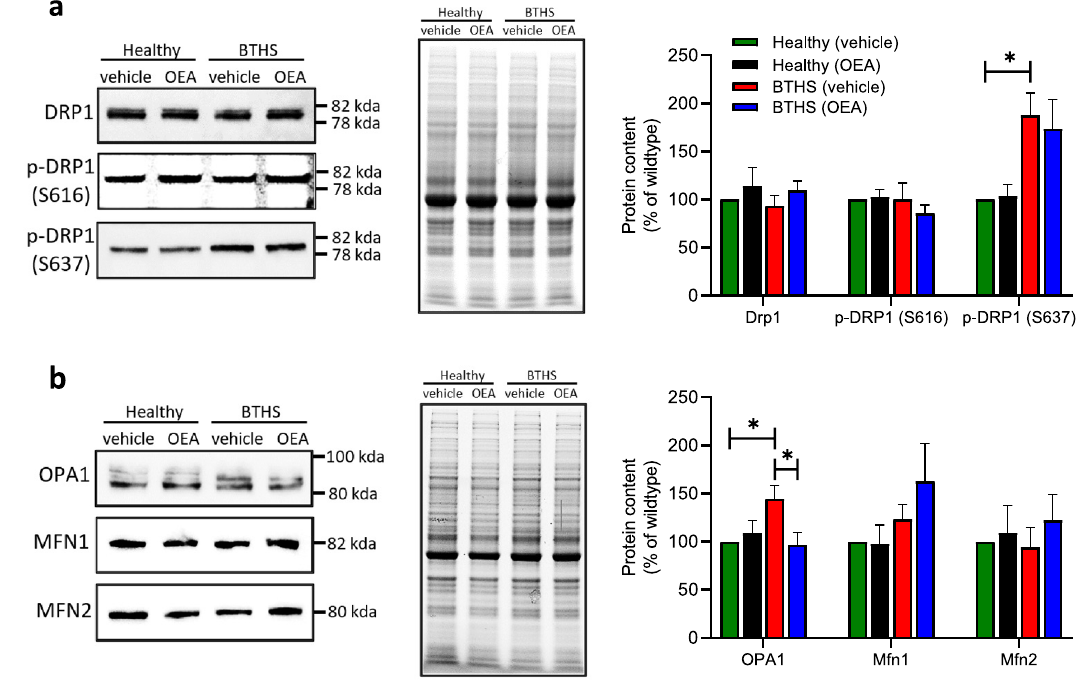
Figure 5. OEA treatment attenuated the elevated expression levels of OPA1 in BTHS lymphoblasts. Representative immunoblots (left panel), images of total protein loading (middle panel), and quantification (right panel) of proteins involved in mitochondrial fission ( a ) and fusion ( b ) are shown. Quantification was determined by Image Lab software (Bio-Rad Canada) and shown normalized to total protein. Uncropped images are presented in Supplementary Figs. S1–S6. Data are means ± S.E.M; n = 5. *P <